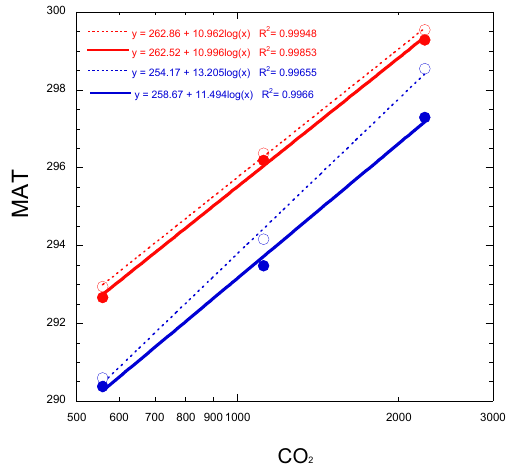
Fig. 4. The unfilled red circles represent the Eocene unglaciated simulations, while the filled red circles represent Eocene glaciated ( α +oro) simulations. The unfilled blue circles represent the mod- ern unglaciated simulations, while the filled blue circles represent modern glaciated ( α +oro) simulations. The atmospheric CO 2 lev- els in ppm (560, 1120, 2240) is plotted on a logarithmic scale on x- axis and the MAT (K) for the glaciated and unglaciated simulations is plotted along the y-axis. A logarithmic line is fitted through the unglaciated and glaciated Eocene and modern cases and the slope, y-intercept, and R 2 values are